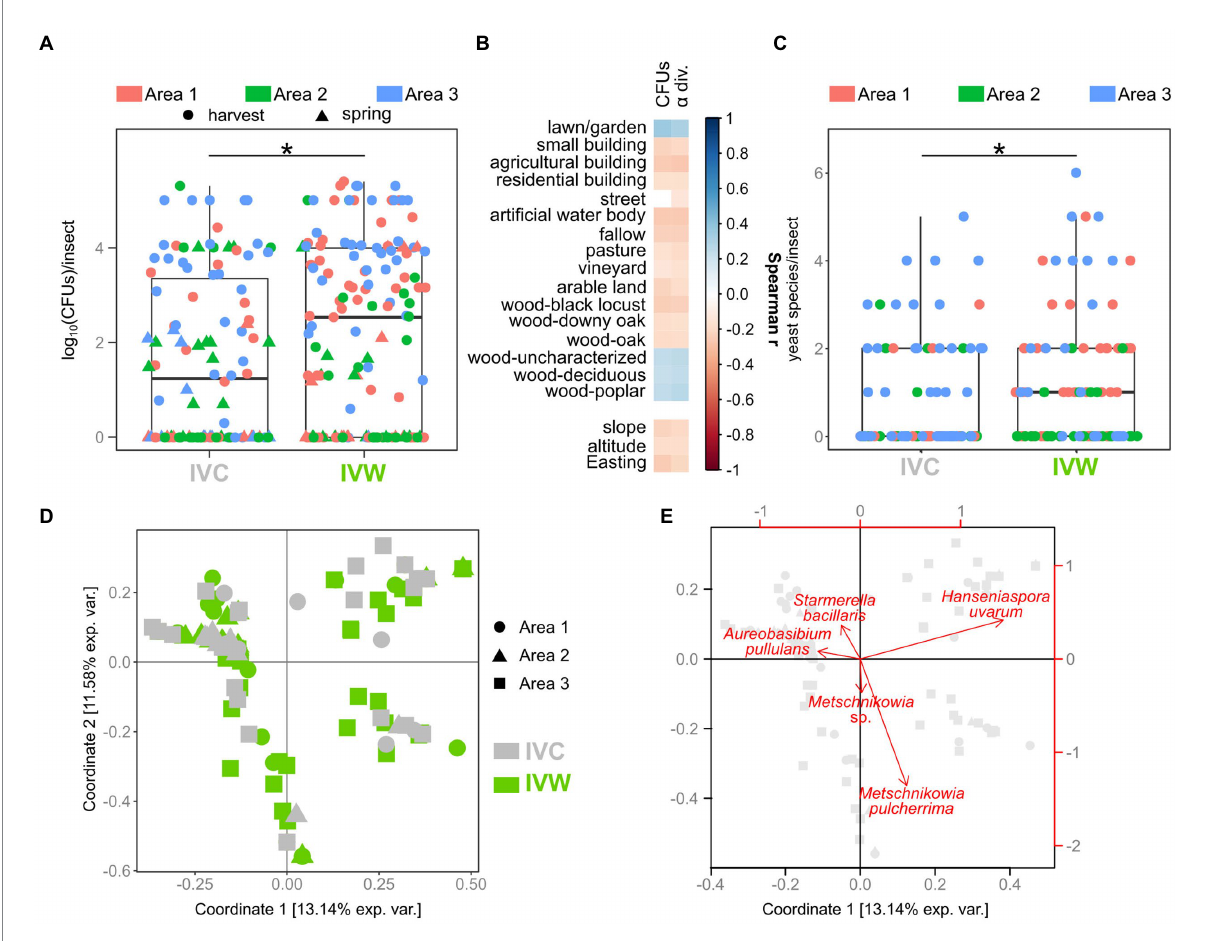
FIGURE 2 Comparison of abundance, biodiversity, and composition of yeast communities. (A) Comparison of yeast abundances in insects caught in vineyards near (VW) and far from (VC) wood. (B) Spearman’s correlations between the number of yeast CFUs and alpha diversity found in the studied insects and the land cover, pedological, and topographical characteristics of the study areas (C) Comparison of yeast alpha diversity of insects caught in VW and VC. (D) Beta diversity of yeast populations in insects caught in VW and VC. Visualization of the first two coordinates of the PCoA based on Jaccard distances calculated on yeast presence/absence data. (E) Projection of the most relevant variables (yeast species) on the first two coordinates of the PCoA based on Jaccard distances. Gray symbols indicate the position of samples, as shown in panel ( D) . * Wilcoxon–Mann–Whitney fdr < 0.05. IVC = Insects caught in Vineyards used as Controls; IVW = Insects caught in Vineyards close to